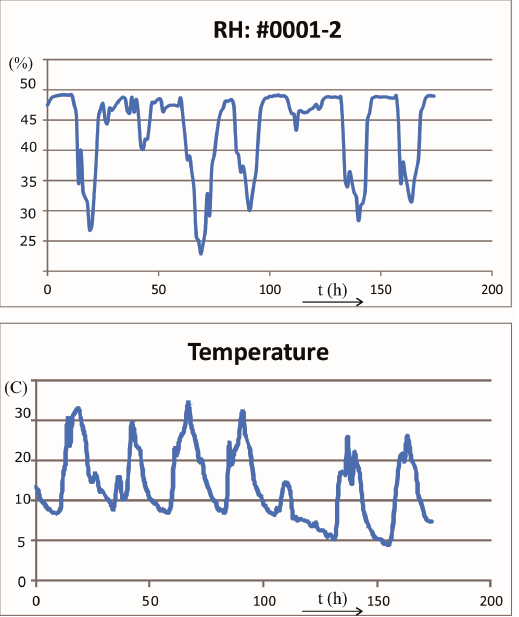
Figure 16. Measured relative humidity using the printed sensor and on board integrated temperature